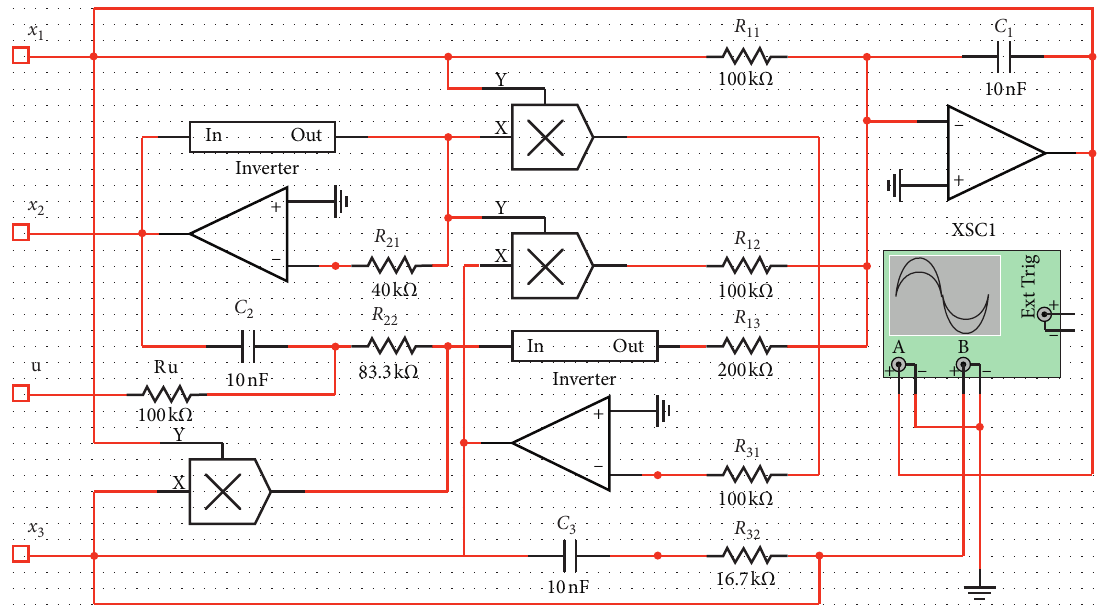
Figure 4: Schematic diagram of the electronic circuit realization of system